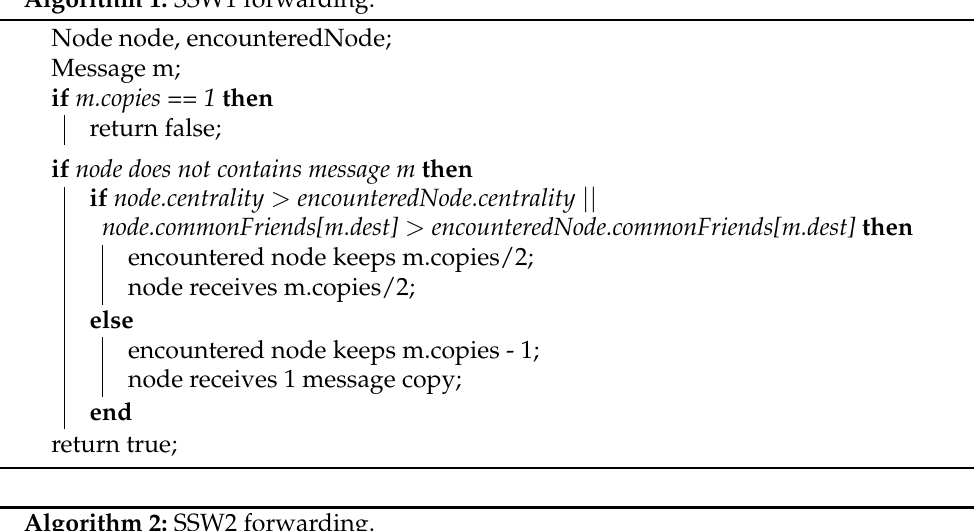
Algorithm 2: SSW2